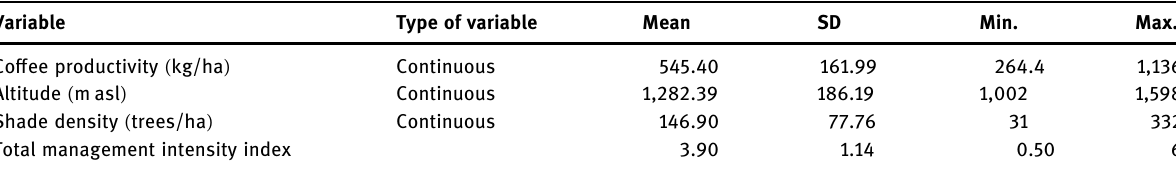
Table 2: Co ff ee plot characteristics ( n = 234 farmers ’ plots )